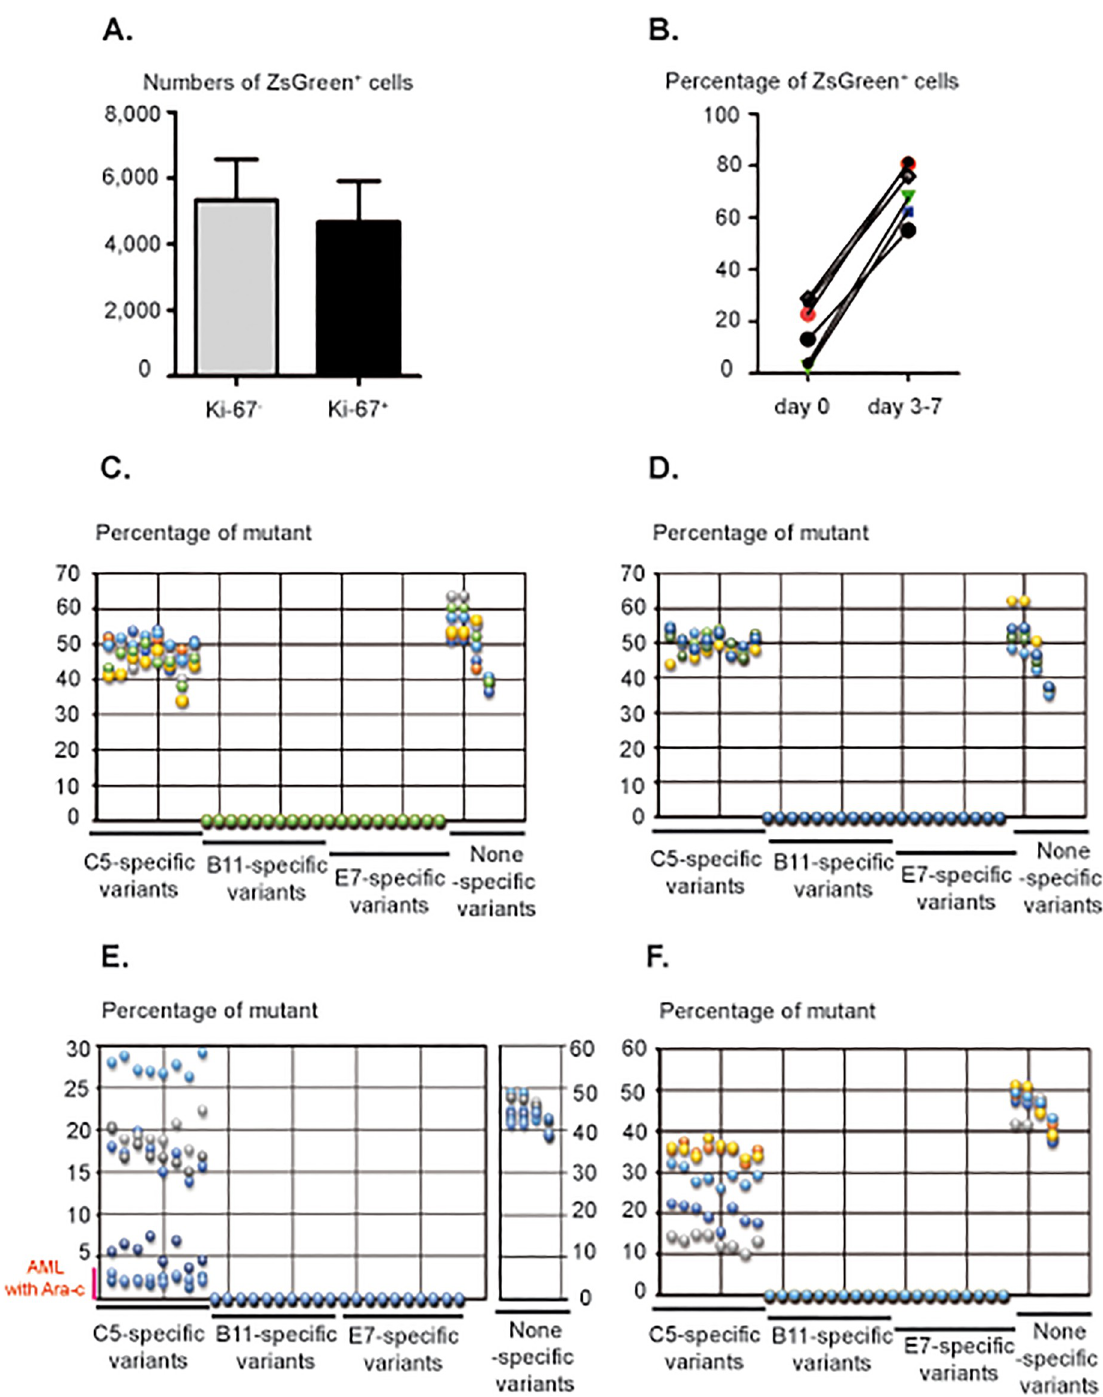
Fig 4. The C5 subclone predominates in the BM and PB of AML-bearing mice. (A) The numbers of leukemic Ki-67-negative and -positive cells in the BM of AML-succumbing mice expressing WT1 or not were determined by flow cytometry (n = 6). (B) In vitro culture of PB derived from AML-bearing mice (B11/C5/E7-injected mice) for 3 to 7 days (n = 6). Leukemic cell enrichment was followed by flow cytometry due to ZsGreen protein expression. (C) Percentages of subclone-specific variants determined by NGS in the PB of leukemic mice following B11/C5/E7 injection (n = 6) and (D) after inoculation with 3 WT1-expressing subclones (n = 5). (E) Frequencies of B11-, C5-, and E7-specific mutants in the BM of leukemic mice after the 3 ZsGreen -expressing subclone injections (n = 5) and Ara-c treatment (n = 2). (F) after B11/C5/E7/WT1 administration (n = 5). Non-specific variants represent mutations found of PB or BM of non-injected (control) mice, their frequencies were also estimated in the BM and PB of leukemic mice (treated or not with Ara-c).